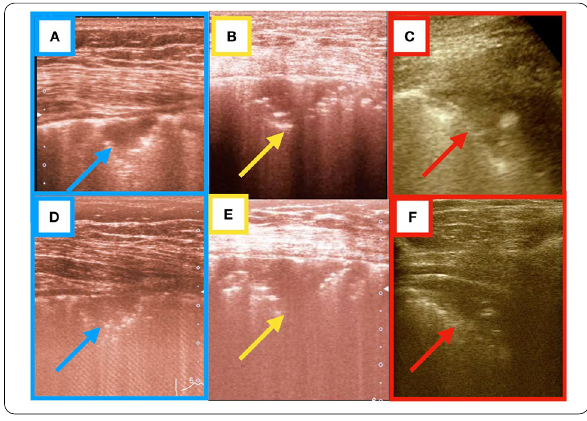
Fig. 1 Brightness-mode ultrasound images of subpleural consolida- tions (arrows) from three different patients with SARS-COV-2 pnemo- nia. A, B and C images correspond to prior contrast administration. (mechanical index 1.3) D, E and F images correspond to the same = subpleural consolidations after sulfur hexafluoride microbubbles (SonoVue) contrast administration showing absent enhancement on CEUS. Mechanical